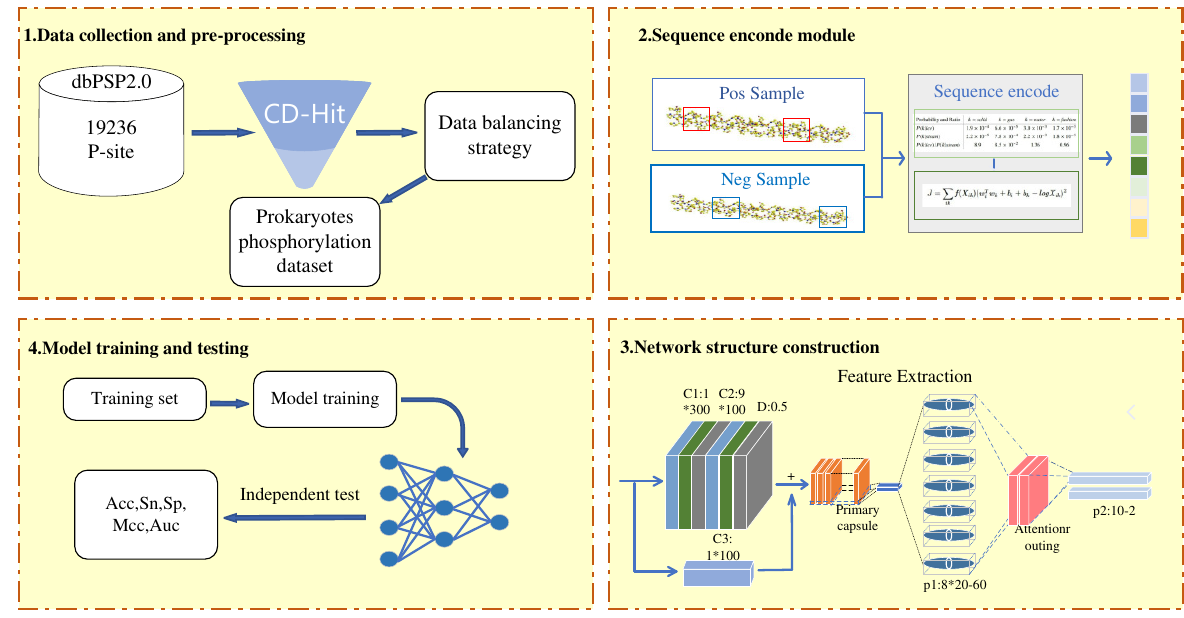
Figure 5. Flowchart of the EcapsP framework. The processes to develop EcapsP include 1. Creation of benchmark dataset, 2. Formulation of samples and calculations of feature vectors, 3. Construction and optimization of the prediction model, 4. Testing and validation of Model. Table 7. The specific information of the benchmark dataset generated by Cd-hit for